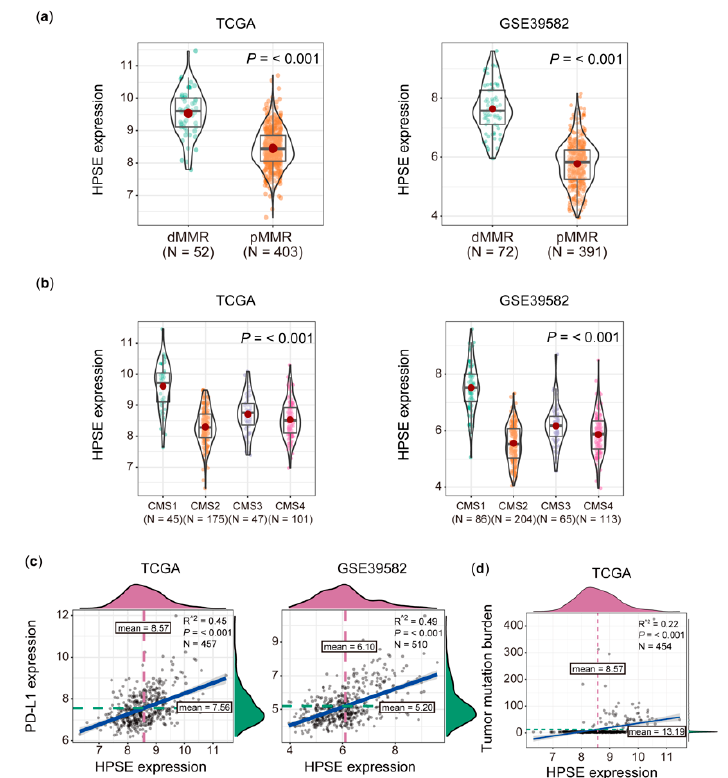
Figure 2. HPSE expression in different molecular subtypes of CRC and its association with PD-L1 expression and tumor mutation burden (TMB). ( a ) HPSE expression in CRC with different MMR status. ( b ) HPSE expression in CRC with different CMS subtypes. ( c ) Correlation analysis between expressions of HPSE and PD-L1. ( d ) Correlation analysis between HPSE expression and TMB. MMR, mismatch repair; dMMR, mismatch repair deficiency; pMMR, mismatch repair proficiency; CMS, consensus molecular subtype.